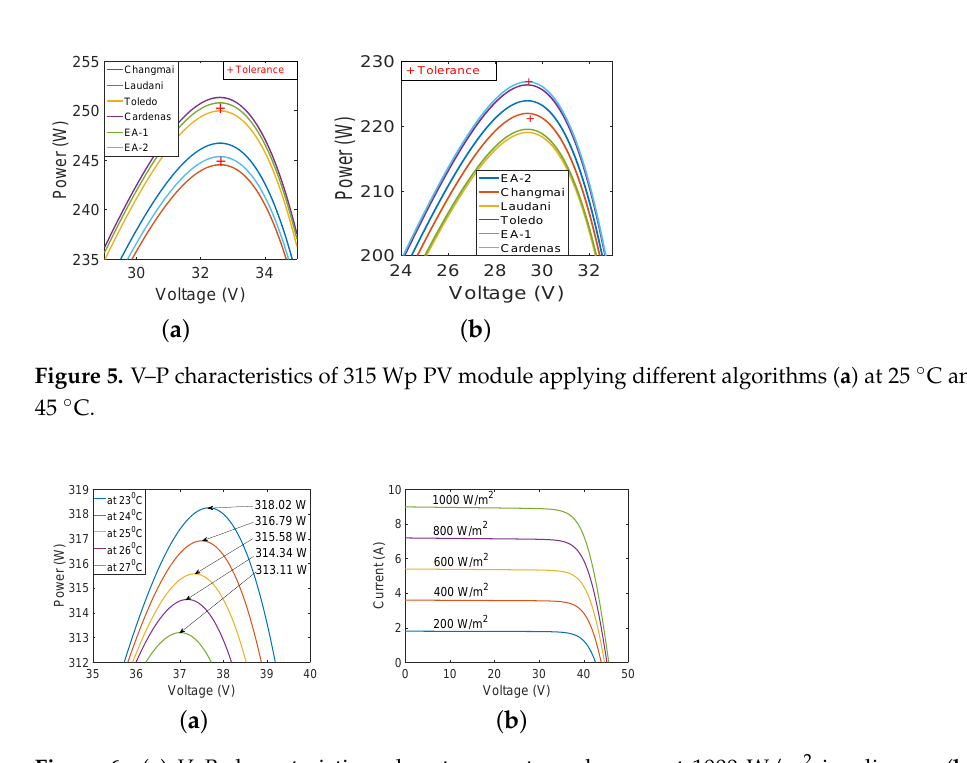
Figure 6. ( a ) V–P characteristics when temperature changes at 1000 W/m 2 irradiance. ( b ) V–I characteristic when irradiance changes at 25 ◦ C